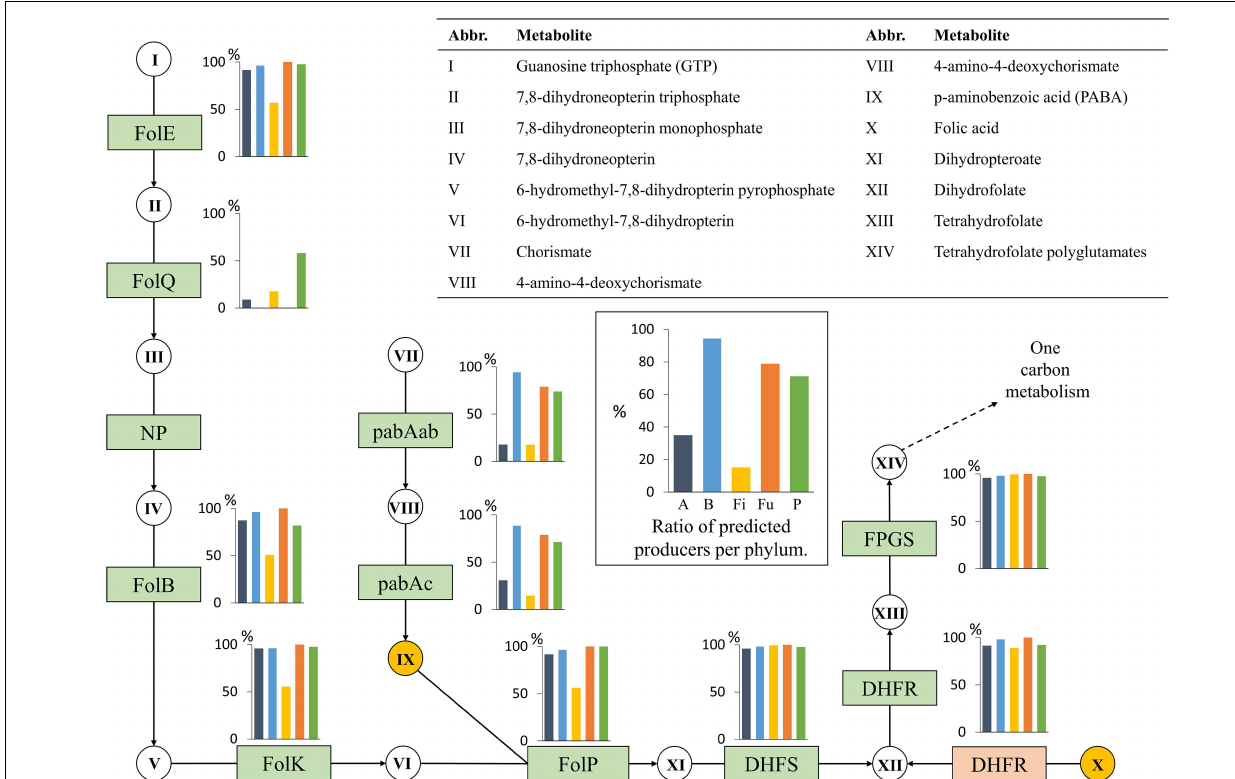
FIGURE 3 | Folate biosynthesis. The folate biosynthesis subsystem contains 11 functional roles (Supplementary Table 2) and 14 metabolites. Refer to Figure 1 for figure descriptions.